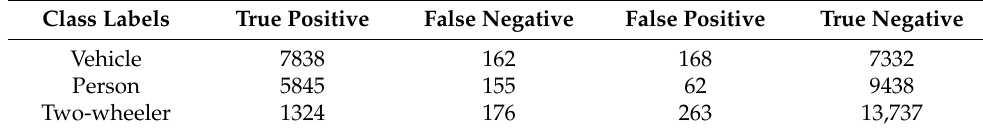
Figure 4. Confusion matrix of CIWHO-ORC technique on Bdd100k Dataset.